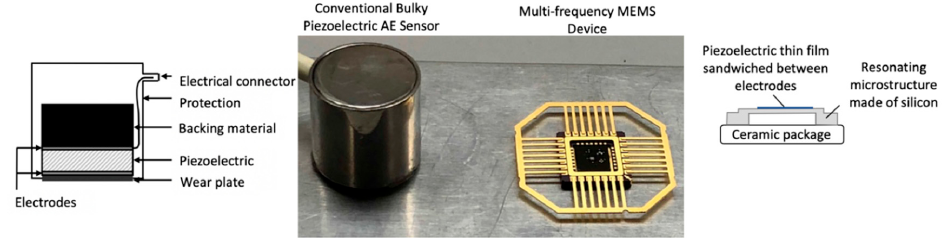
Figure 2. The comparison of conventional piezoelectric bulky AE sensor and piezoelectric micro-electro- mechanical-systems (MEMS) AE sensor designed by Ozevin’s research group.